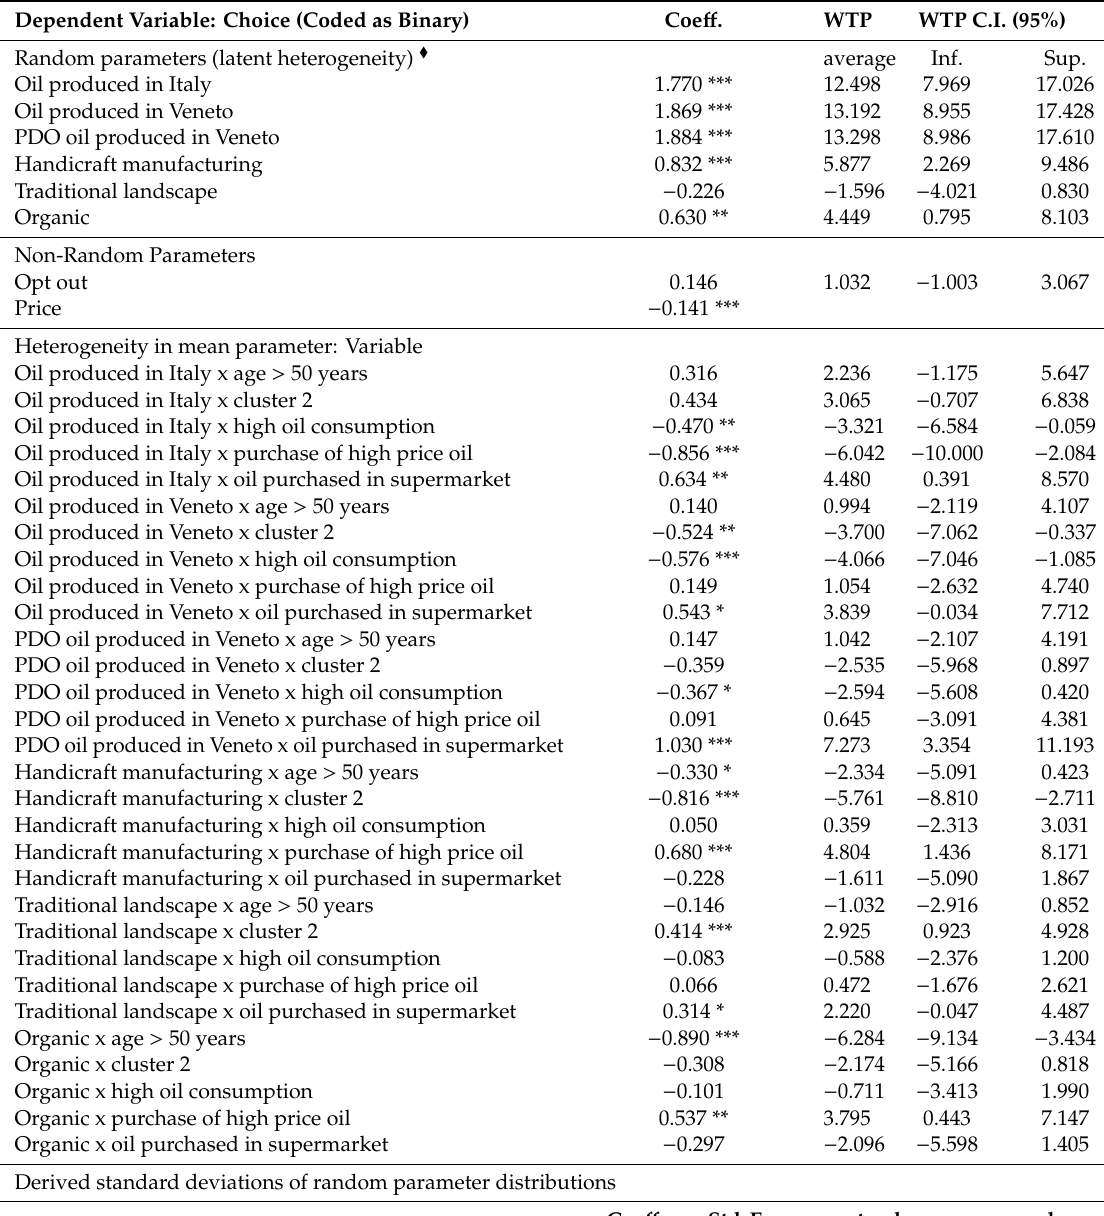
Table 5. RPL model